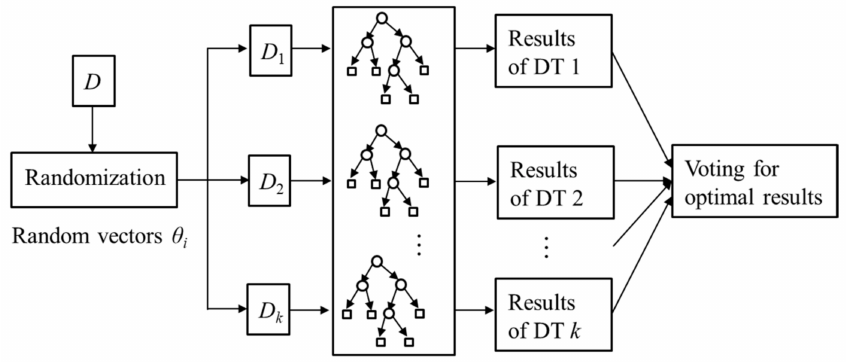
Figure 6. Architecture of